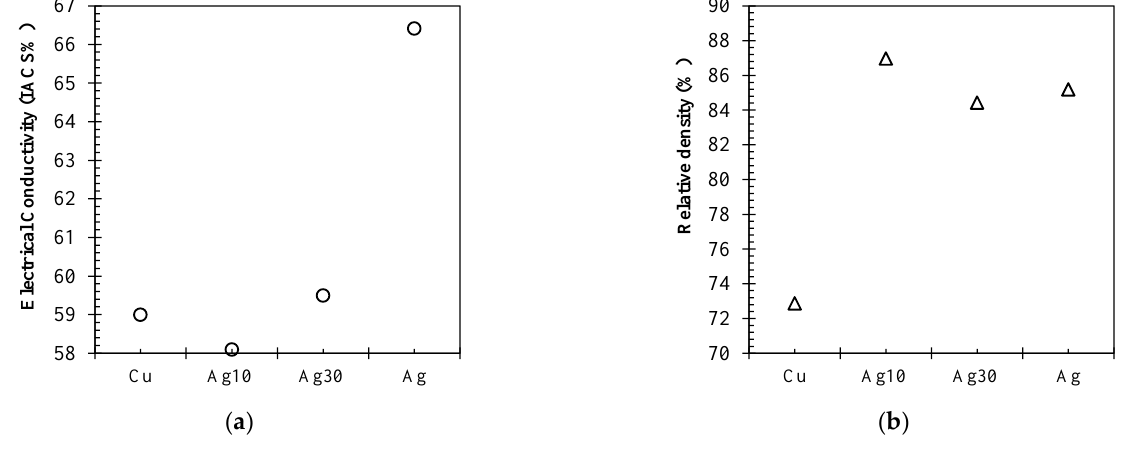
Figure 7. IACS electrical conductivity performance ( a ) and XCT relative density ( b ) for EOS Cu (>99%), CuAg10, CuAg20 and Legor Ag high-purity feedstocks. Powder Recoating and Laser Exposure